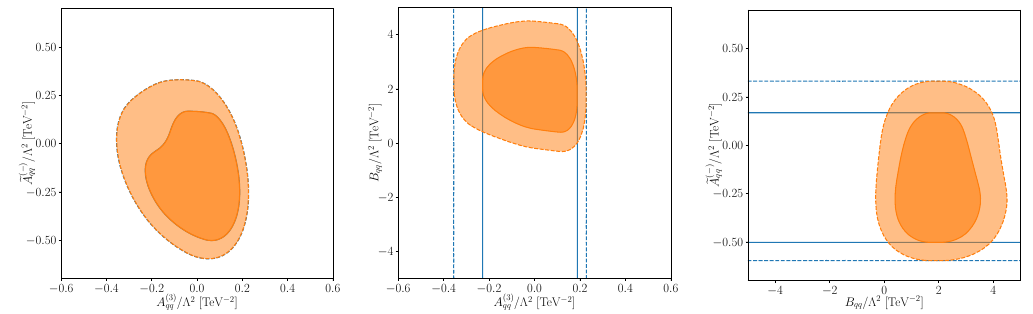
Figure 7 . Flavor universality test of the four-quark Wilson coefficients C ( − ) qq ( m t ) = C (1) qq − C (3) qq and C (3) qq ( m t ) in MFV. Shown are the bounds obtained from a three-parameter fit of { A (3) qq , e A ( − ) qq , B qq } to top (blue) and top & B + µ − (orange) data at ∆ χ 2 = 2 . 30 (solid) and ∆ χ 2 = 5 . 99 s → µ